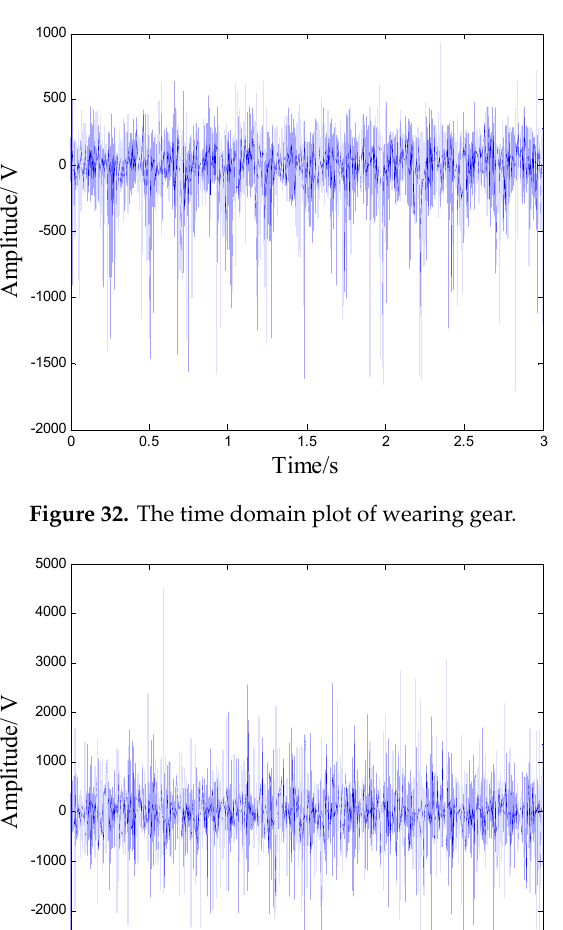
Figure 31. The time domain plot of broken gear.